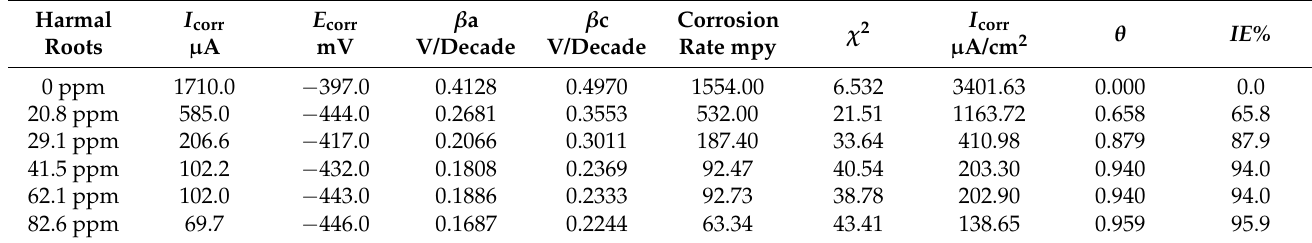
Table 8. Polarization parameters for various concentrations of Harmal roots extract on the C-steel in